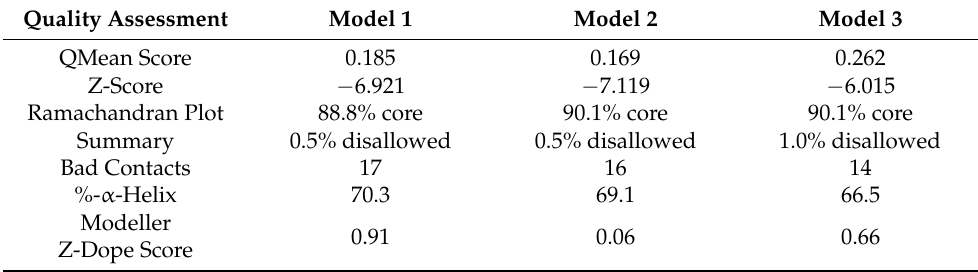
Table 2. Quality assessment of top homology